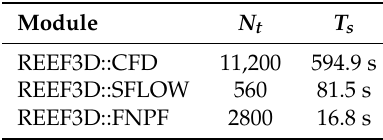
Table 1. Comparison of total number of cells N t and simulation time T s in seconds for the simulation of progressive linear wave using the three